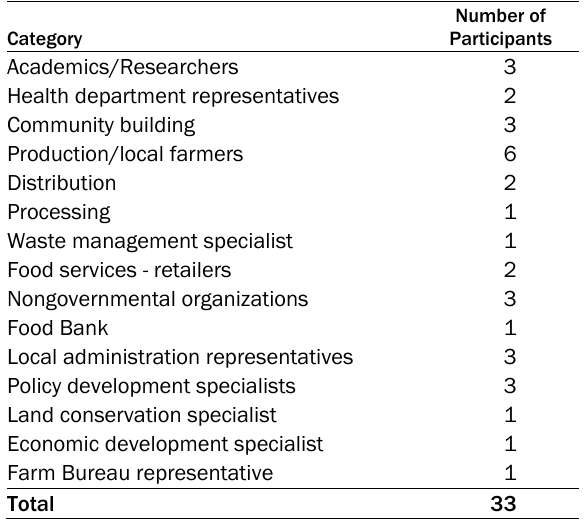
Table 1. Activities and Responsibilities